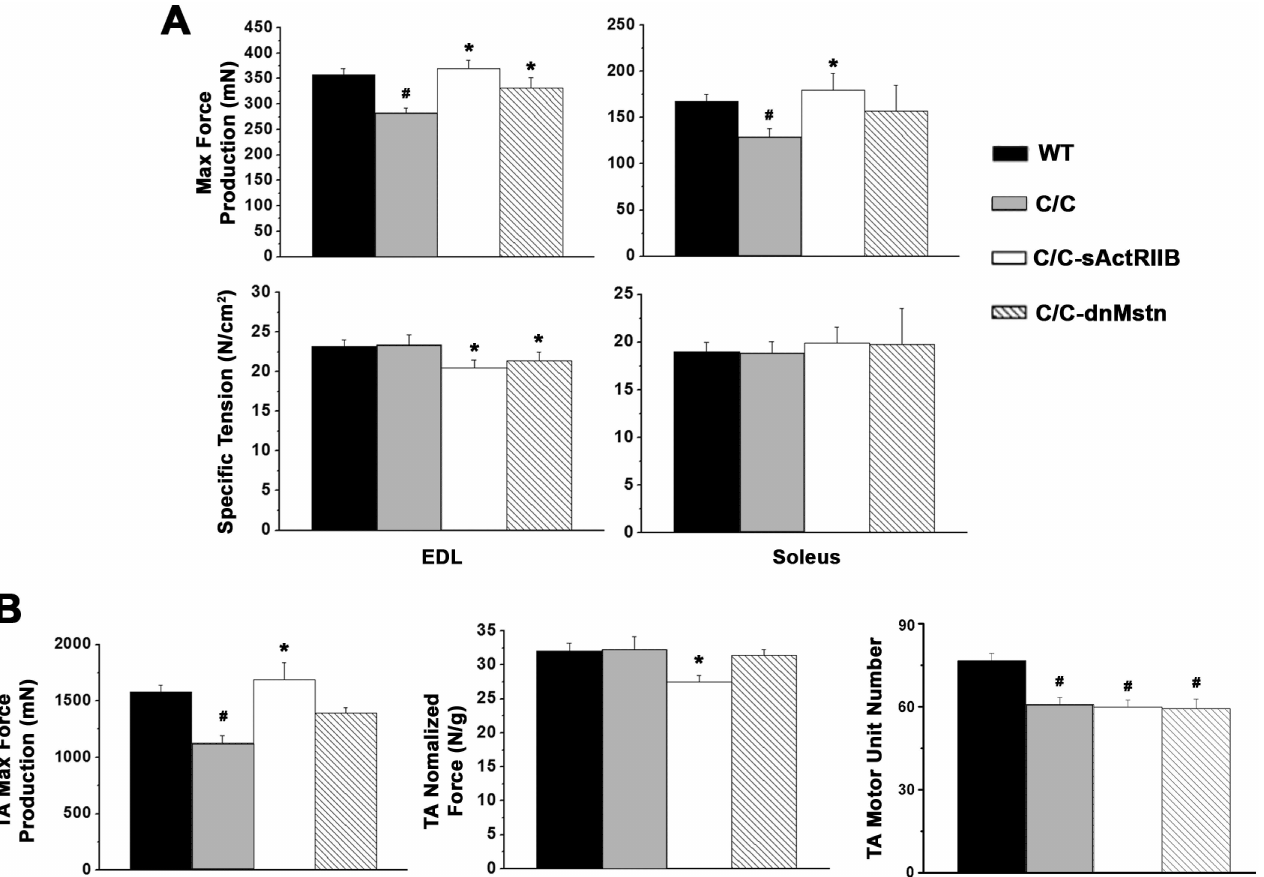
Fig 3. Activin inhibition improves contractile properties of SMA C/C mice. ( A ) Muscle contractilepropertiesof extensor digitorumlongus(EDL; in situ ) and soleus ( ex vivo ) muscles from 12 week-oldwild-type(WT; n = 6) and SMA C/C mice from control (C/C; n = 6), AAV8.LSP.sActRIIB (C/C- sActRIIB; n = 6), and AAV8.LSP.dnMstn (C/C-dnMstn; n = 6) treatment groups in terms of absolute peak tetanic isometric force production (top) and specific tension (bottom). ( B ) In situ contractilepropertiesof the tibialisanterior (TA), in terms of absolutepeak tetanic isometric force production (left) and mass-normalized force (middle). TA motor unit number was also evaluated(right). Data are displayedas mean ± SEM and analyzedusing one-way ANOVA (Bonferroni-Dunn post-hoc tests; # p < 0.05 vs. WT values; * p < 0.05 vs. control C/C values).